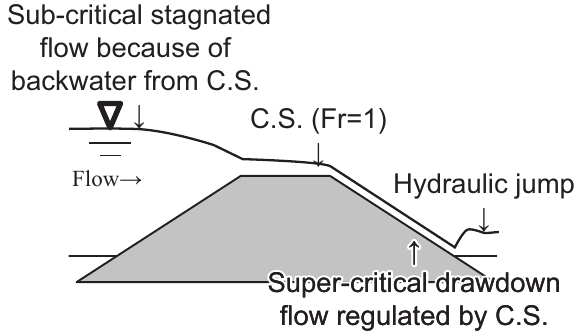
Figure 6. Schematic diagram of one-dimensional flow over em- bankment. C.S. in figure corresponds to the critical section where the flow is